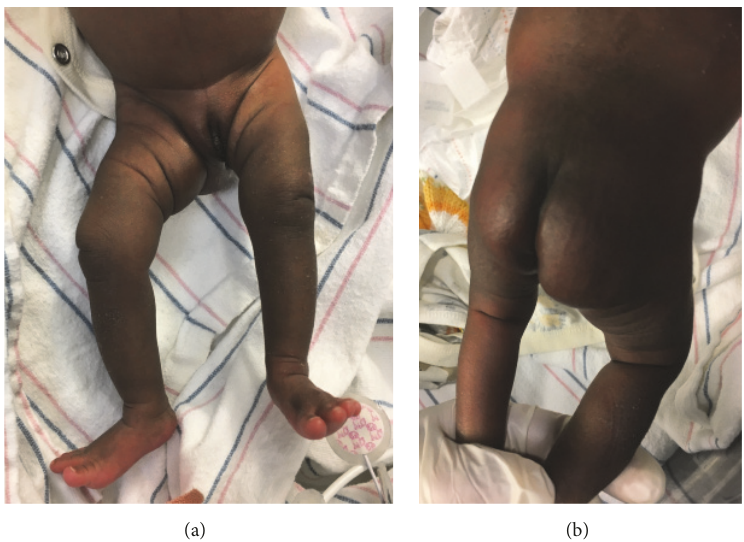
Figure 7: (a) and (b) Photos showed hemihypertrophy.